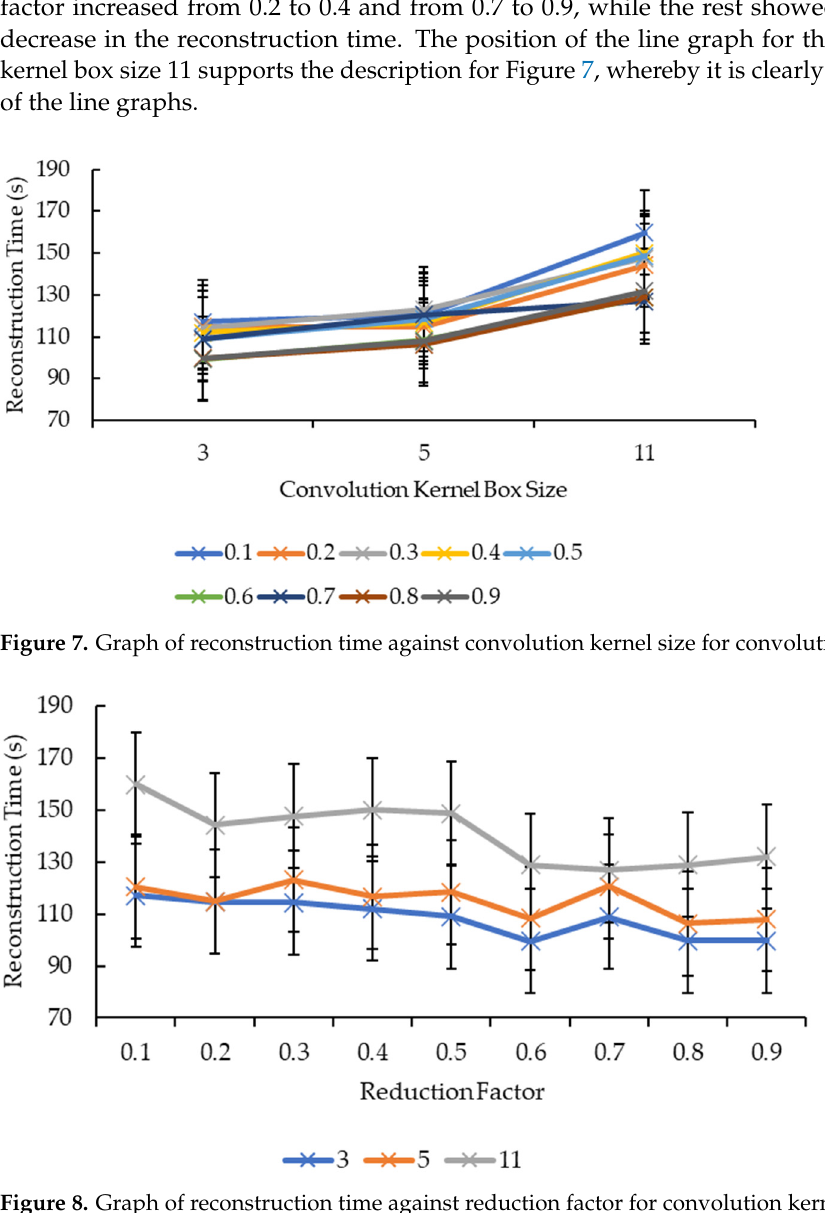
Figure 8. Graph of reconstruction time against reduction factor for convolution kernel box.